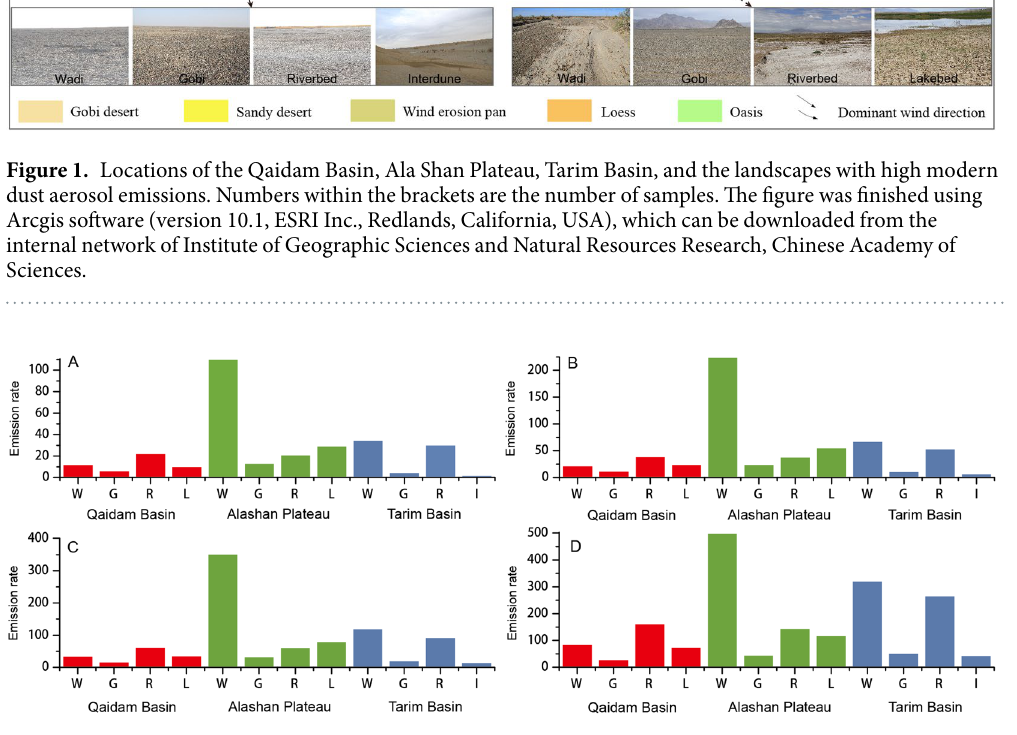
Figure 2. Availabilities of PM2.5 ( A ), PM5 ( B ), PM10 ( C ), and PM50 ( D ) (g m − 2 ) during one aeolian event